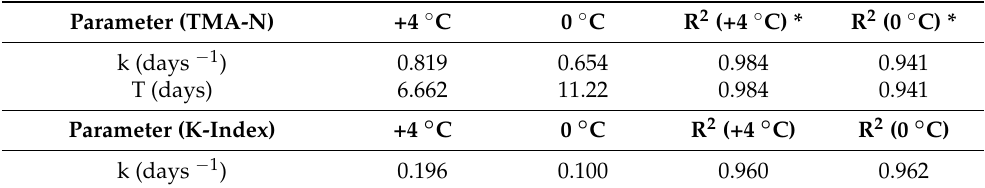
Table 1. Kinetic parameters estimated from exponential models for TMA-N concentrations and K-Index values in red mullets ( Mullus barbatus ) at +4 ◦ C and 0 ◦ C.